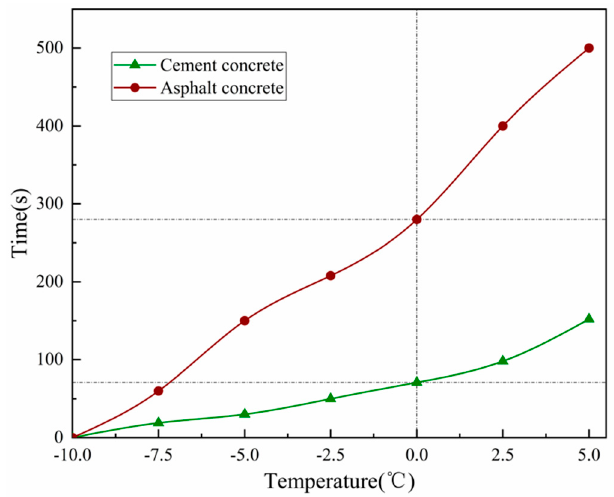
Figure 11. Temperature change chart of concrete G points of different pavement materials at 2.45 GHz frequency.